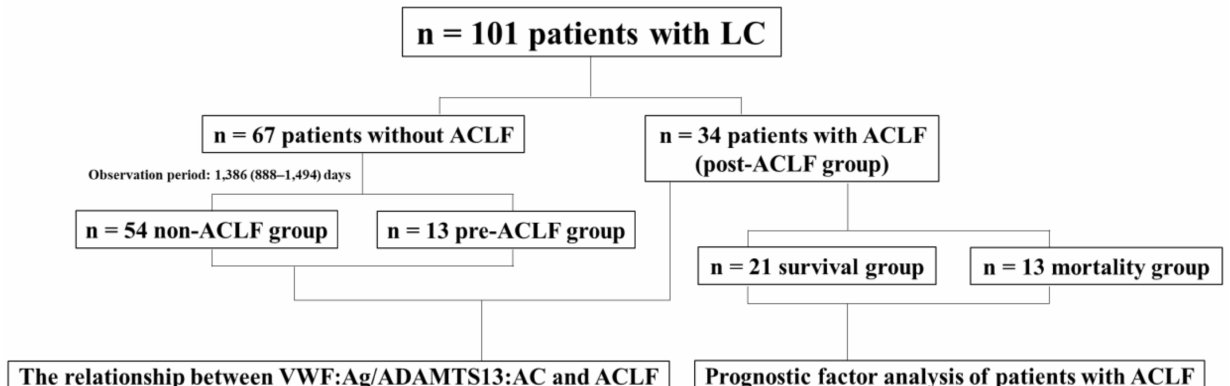
Figure 1. Study Design. We initially investigated the relationship between ADAMTS13:AC and VWF:Ag and the non-ACLF group, pre-ACLF group, or post-ACLF group. Subsequently, we assessed the relationship between ADAMTS13:AC and VWF:Ag and prognosis in patients with LC in the post- ACLF group. ACLF, acute-on-chronic liver failure; LC, liver cirrhosis; ADAMTS13, a disintegrin-like and metalloproteinase with thrombospondin type 1 motifs 13; ADAMTS13:AC, ADAMTS13 activity; VWF, von Willebrand factor; VWF:Ag, VWF